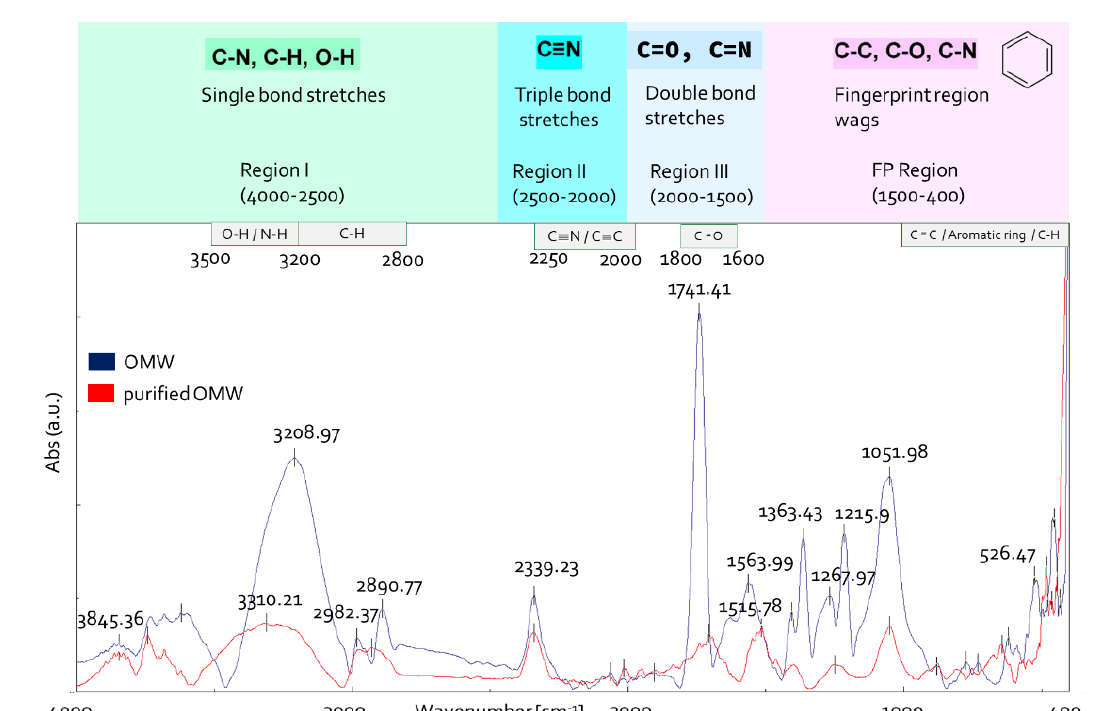
Figure 5. OMW IR spectra before and after purification.